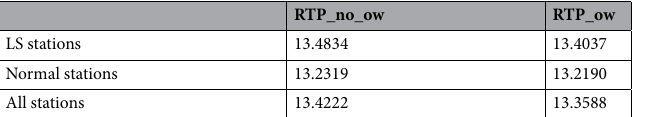
Table 1. Average RMSE for land-sea (LS) and normal stations for RTP pre-trained with (RTP_ow) and without (RTP_no_ow) ocean wind.